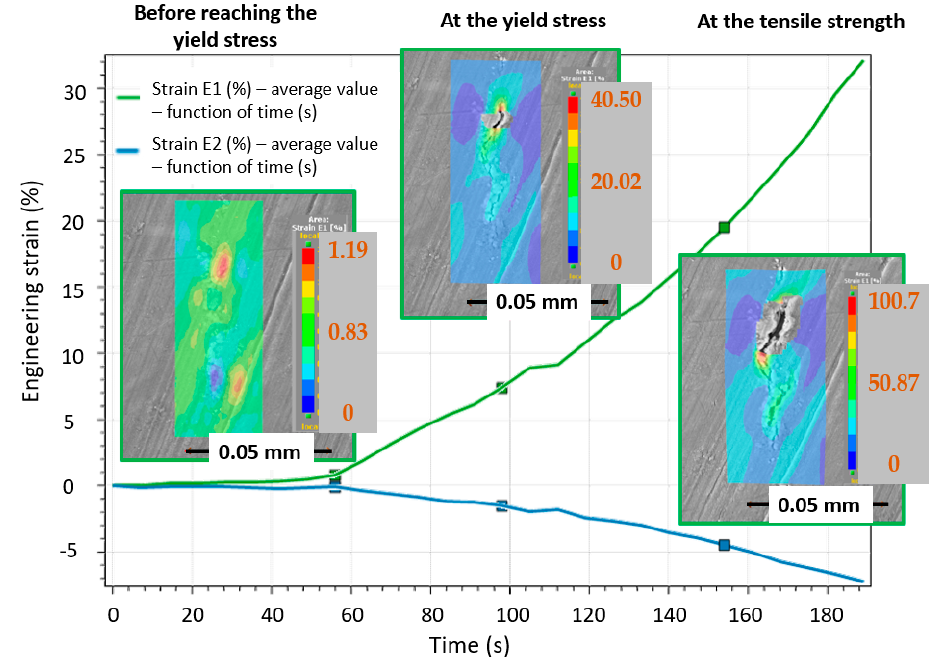
Figure 22. DIC analysis of the engineering strain distribution in the intermetallic particle during tensile loading: at the beginning of the tensile loading, at the yield strength, and at the tensile strength limit.